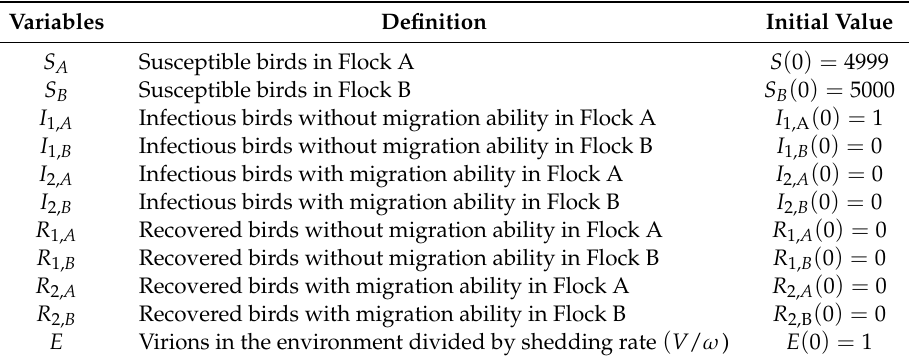
Table 2. The variables of the